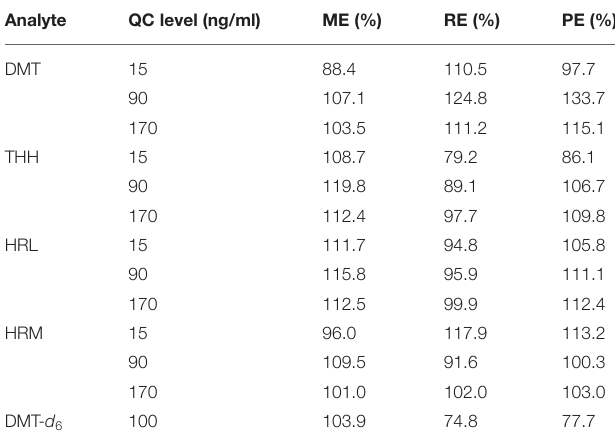
TABLE 6 | Percentage of matrix effect (ME%), recovery (RE%), and process efficiency (PE%) after submitting spiked urine samples to HF-LPME and UPLC-MS/MS